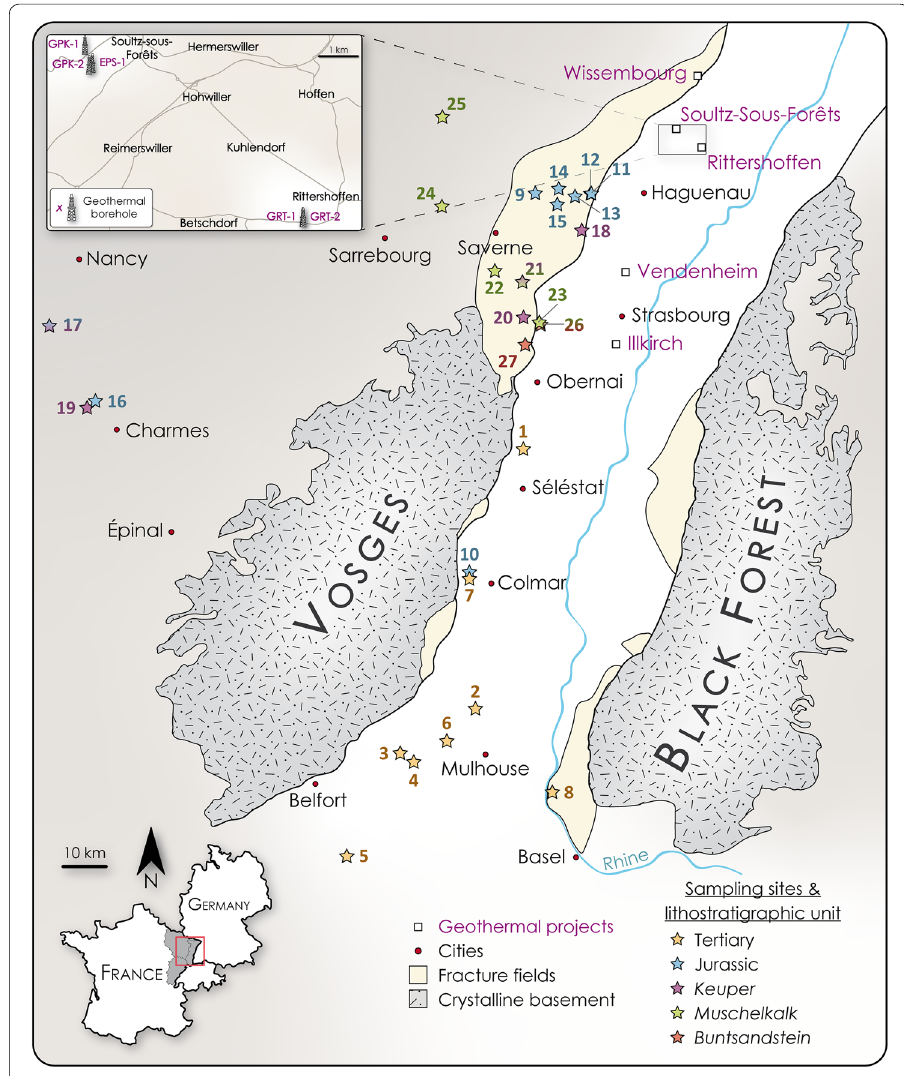
geothermal projects. Numbered stars refer to sampling locations, given in Figs. 2 and 3. The color of the stars indicates the lithostratigraphic unit. More than one lithostratigraphic unit was sampled in locations 17, 21 and 26 (modified after Aichholzer et al.